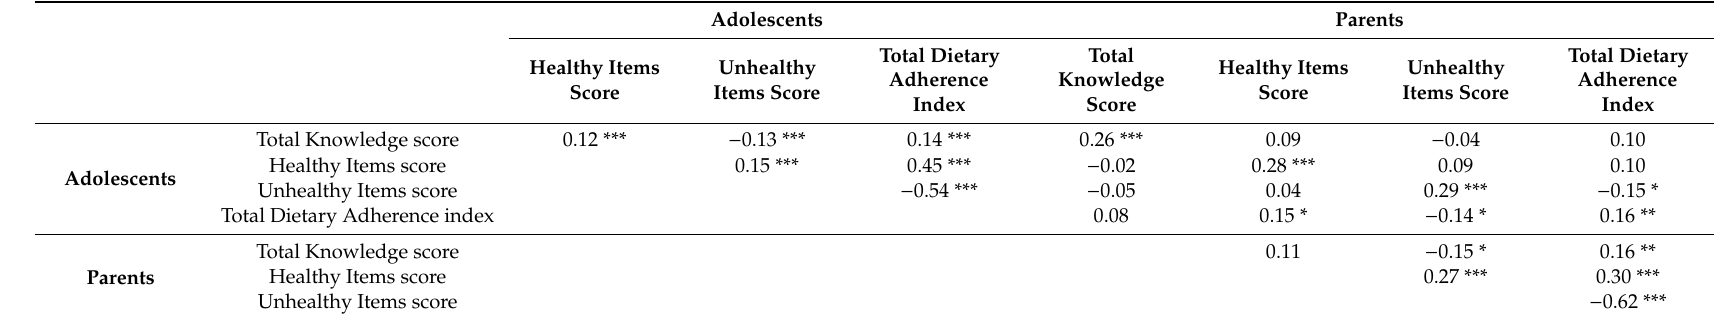
Table 4. Correlations between knowledge and adherence scores of the adolescents and their parents.